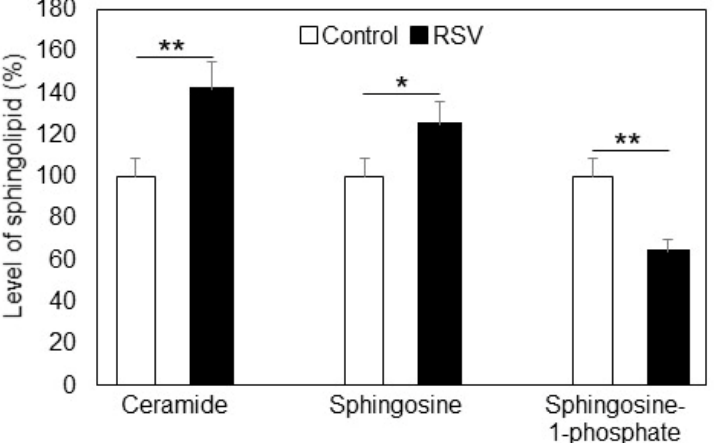
Figure 4. Changes in the level of ceramide, sphingosine, and sphingosine-1-phosphate in control (Control, white bars) and resveratrol-treated (RSV, black bars) A549 cells. Values are expressed as % of controls (100%). Values are means ± SD. The differences between the values obtained for ceramide (** p < 0.001), sphingosine (* p < 0.01), and sphingosine-1-phosphate (** p < 0.001) were statistically significant.